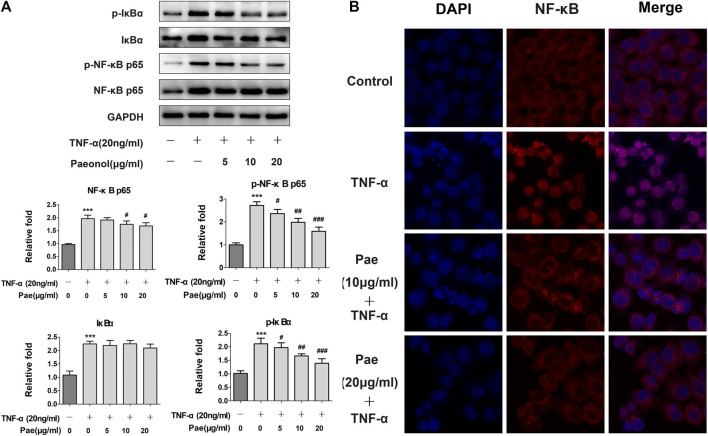
Paeonol disrupts NF-κB signaling in A549 cells stimulated with TNF-α. A549 cells were treated with paeonol at indicated concentrations and/or TNF-α (20 ng/ml) for 24 h. (A) Western blot analyses of IκBα, p-IκBα, NF‐κB p65 and p‐NF‐κB p65 with quantification. GAPDH was used as an invariant control for equal loading and representative blots were from three independent experiments (n = 3). Significance: ***p < 0.001 vs. control, #p < 0.05 vs. TNF-α, ## p < 0.01 vs. TNF-α, ### p < 0.001 vs. TNF-α. (B) Immunofluorescence double staining for determining NF‐κB (p65) nuclear translocation. Original magnification ×400. Representative images are shown from triplicate experiments.